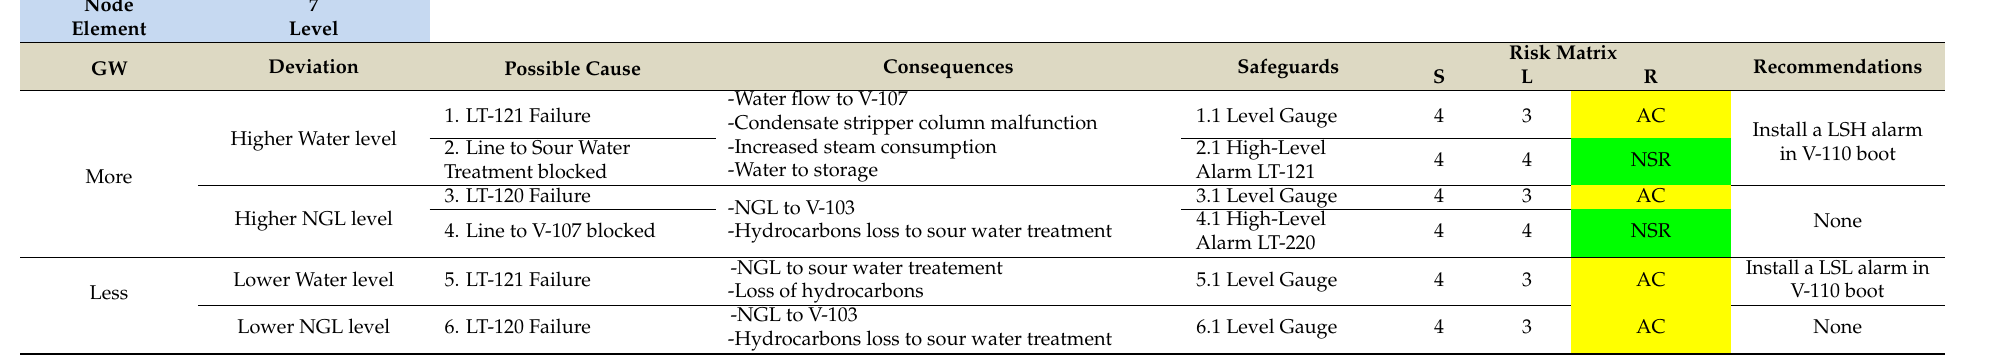
Table 5. HAZOP study results for the deviations specified in the SCOPI’s Node #7 concerning the element “Level”, in association with (i) risk-matrix outcomes and the SC coding, and (ii) the depiction of appropriate guidewords, possible causes, consequences, safeguards and recommendations.